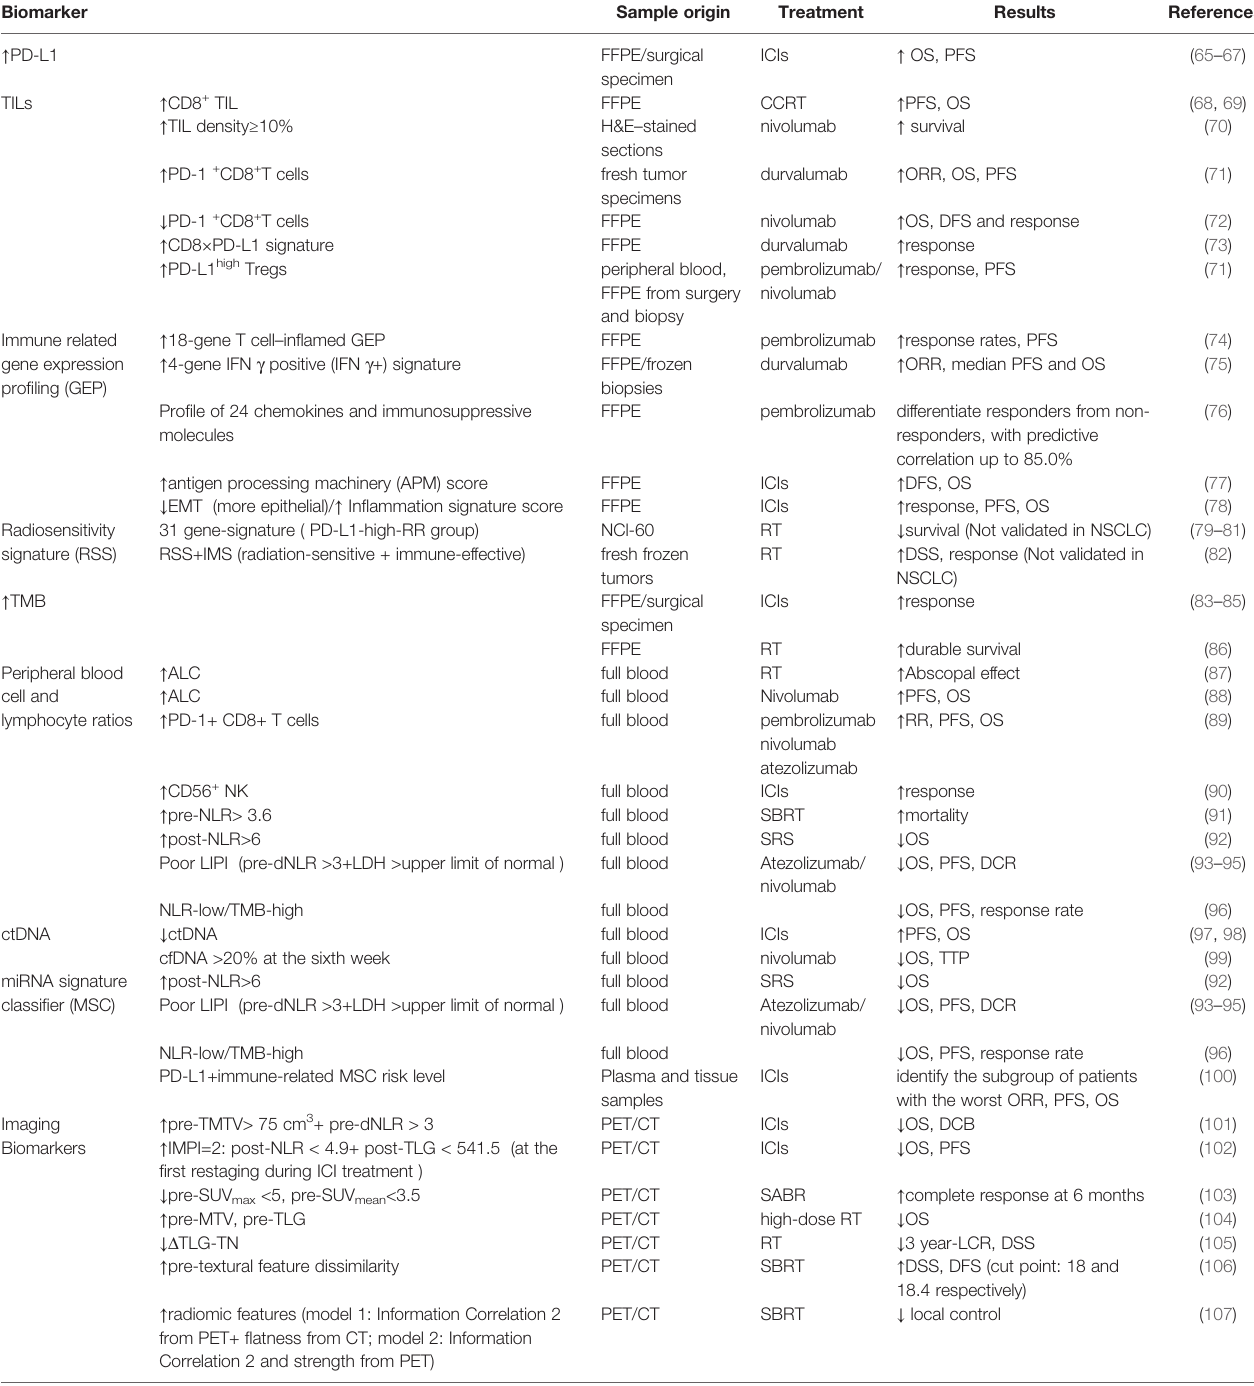
FFPE, formalin- fi xed paraf fi n-embedded; ICIs, immune checkpoint inhibitors; RT, radiotherapy; CCRT, concurrent chemoradiotherapy; SBRT, stereotactic Body Radiotherapy; SABR, stereotactic ablative radiotherapy; SRS, stereotactic radiosurgery; OS, overall survival; PFS, progression free survival; TTP, time to progression; DFS, disease free survival; DCB, disease clinical bene fi t; ORR, overall response rates; DSS, disease speci fi c survival; DCR, disease control rate; LCR, local control rate; EMT, epithelial mesenchymal transition; NCl-60, National Cancer Institute panel of 60 cell lines; SF2, survival fraction at 2 Gy; IMPI, immune-metabolic-prognostic index, ↑ increased; ↓